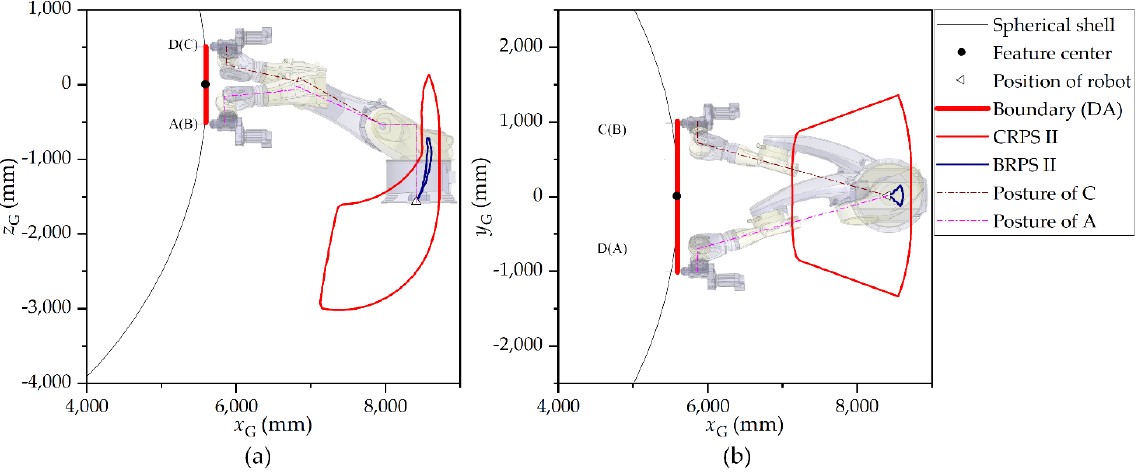
Figure 10. Placement space meeting reachability constraints.